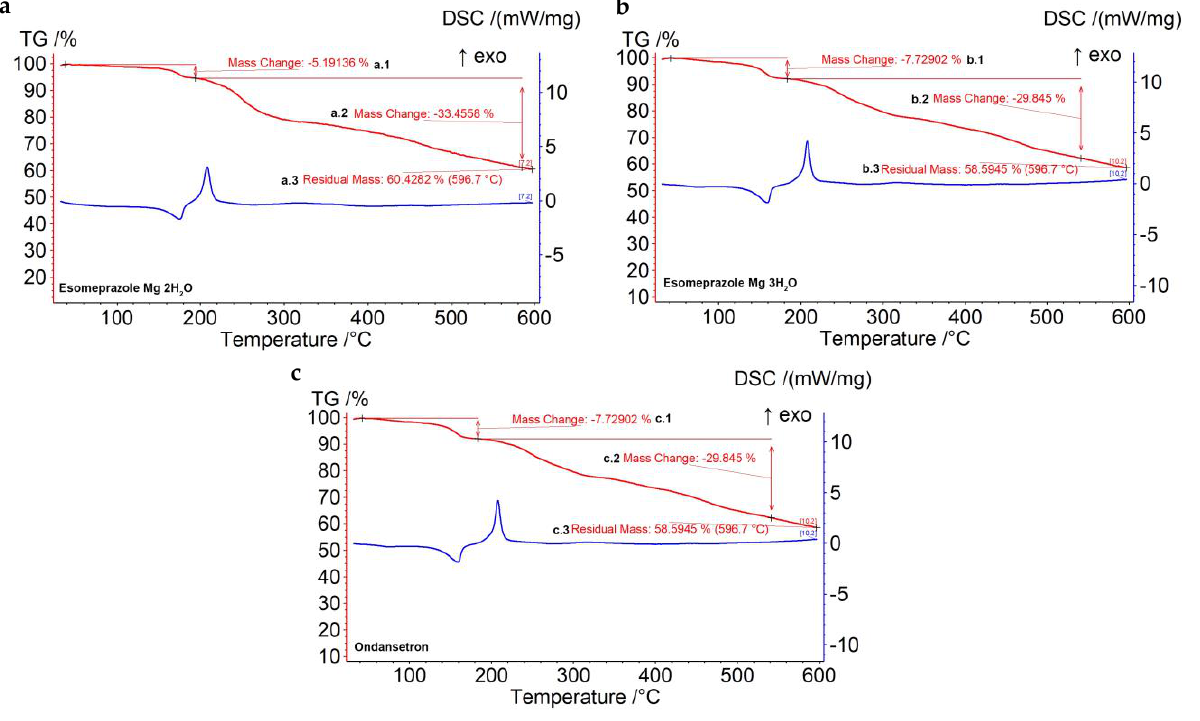
Figure 3. STA thermograms of active pharmaceutical ingredients (APIs): ( a ) Esomeprazole Mg 2H 2 O